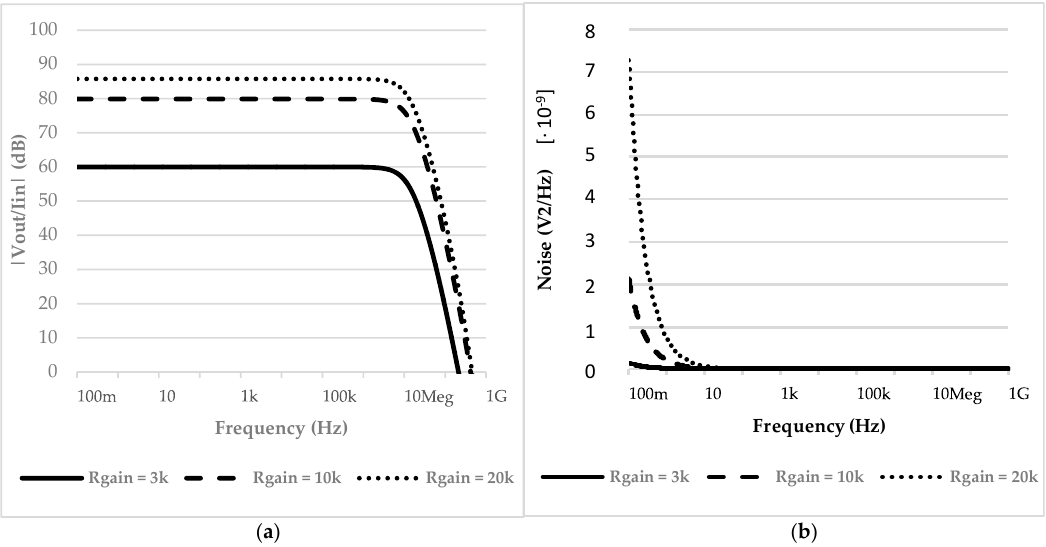
Figure 6. ( a ) Transimpedance amplifier (TIA) transfer function at different gain levels; ( b ) TIA output equivalent noise at different noise levels.